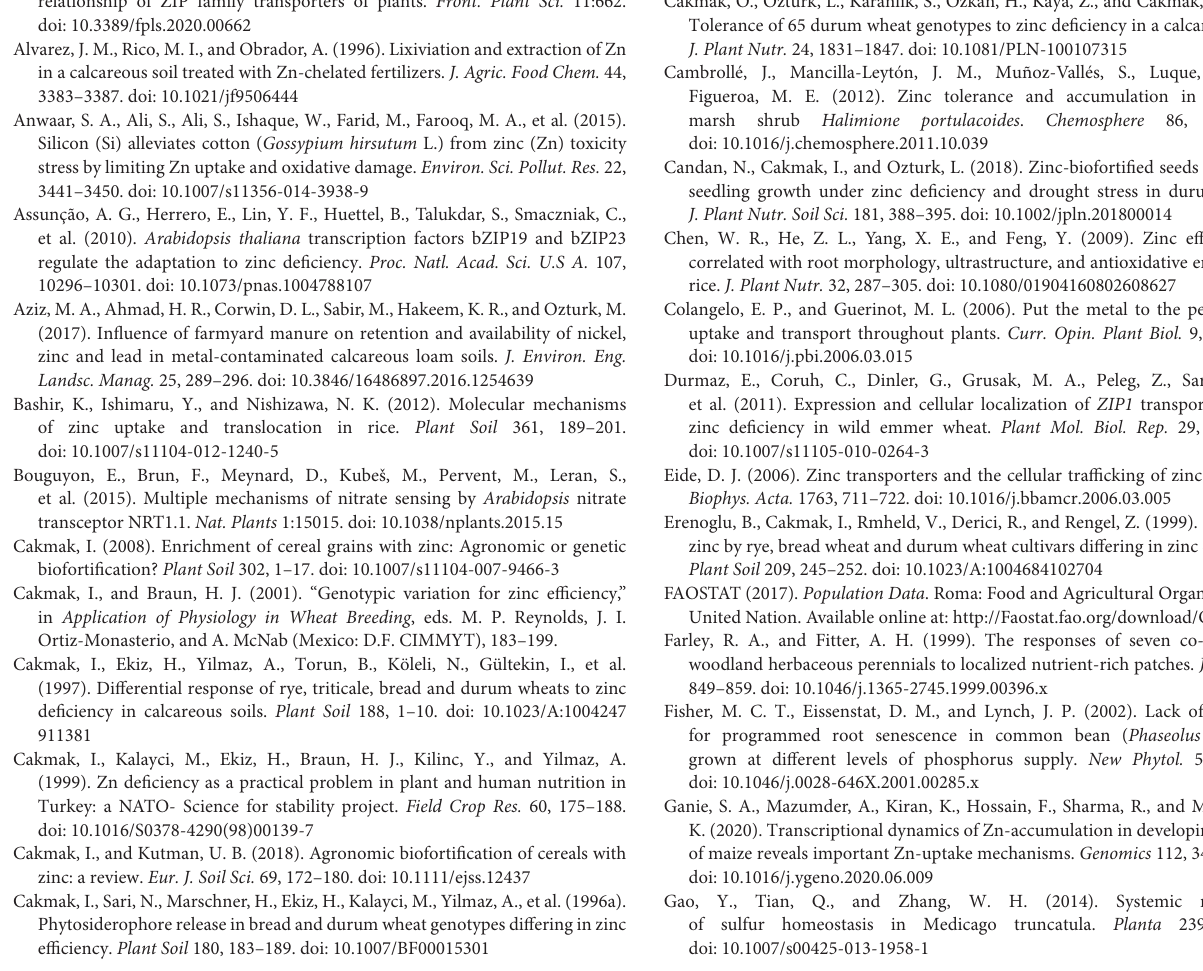
Figueroa, M. E. (2012). Zinc tolerance and accumulation in the salt- marsh shrub Halimione portulacoides . Chemosphere 86,